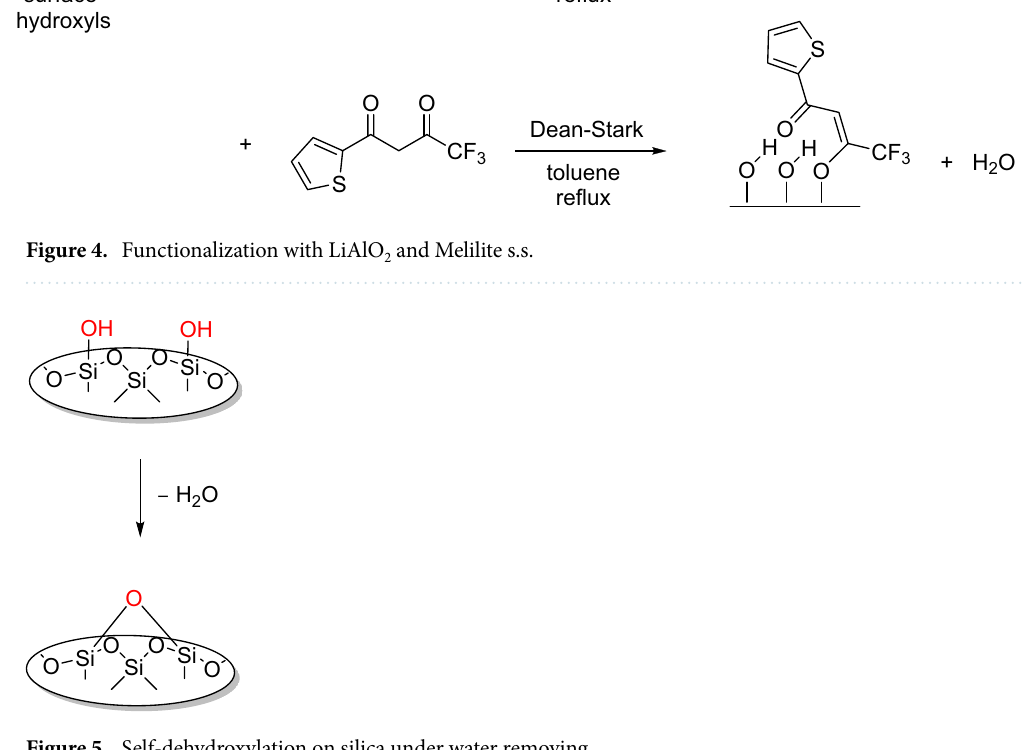
Figure 5. Self-dehydroxylation on silica under water